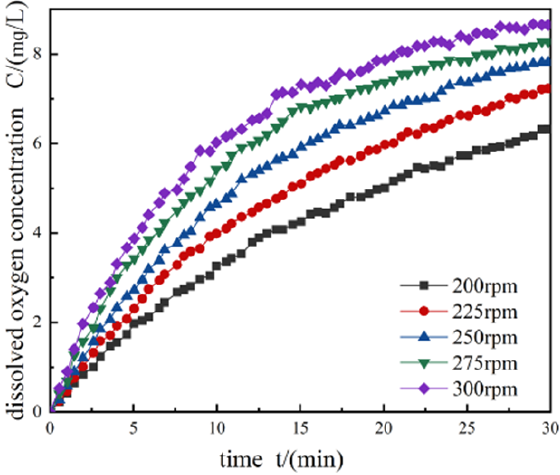
Figure 7. The dissolved oxygen concentrations at different speeds.